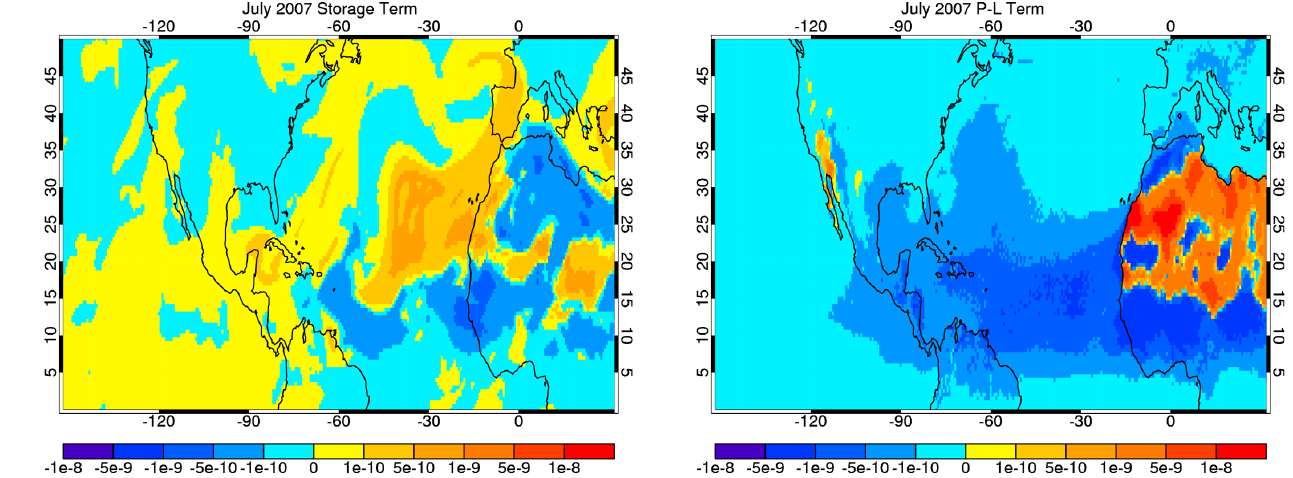
Fig. 8. July 2007 storage term (kgm − 2 s − 1 ) as described in Sect. 4.1.1.